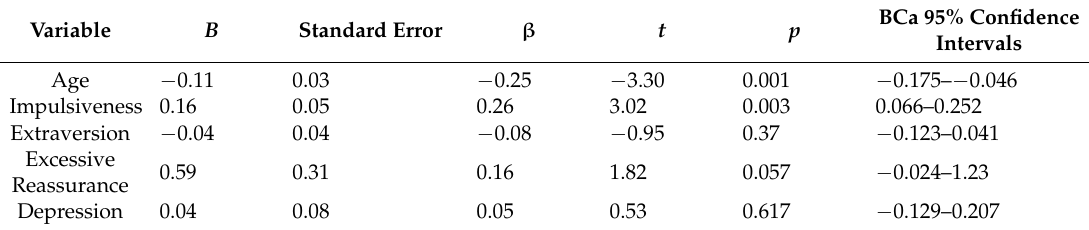
Table 4. Bootstrapped ª multiple regression model of predictors of problematic smartphone use with BCa 95% confidence intervals ( N =